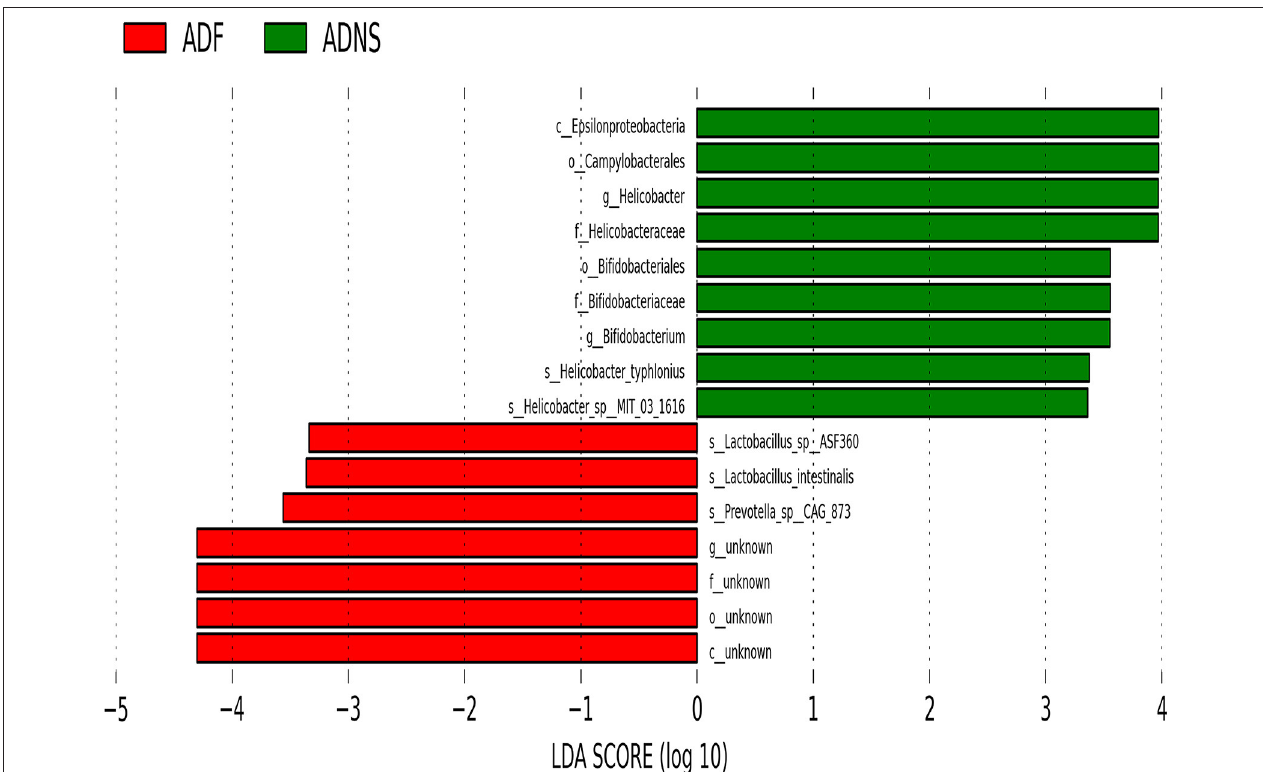
FIGURE 5 | Linear discriminant analysis (LDA) effect size (LEfSe) analysis of microbiota in ADF (negative score) relative to ADNS (positive score). The LDA scores (log10) > ± 3 were more abundant at the species level in ADNS compared to WT. s_Prevotella_sp_CAG873 was identified as a potential biomarker in response to fasudil treatment in APP/PS1 mice (ADF), while s_Helicobacter_typhlonius and s__Helicobacter_sp_MIT_03-1616 were identified as potential biomarkers in APP/PS1 mice (ADNS); n = 5.